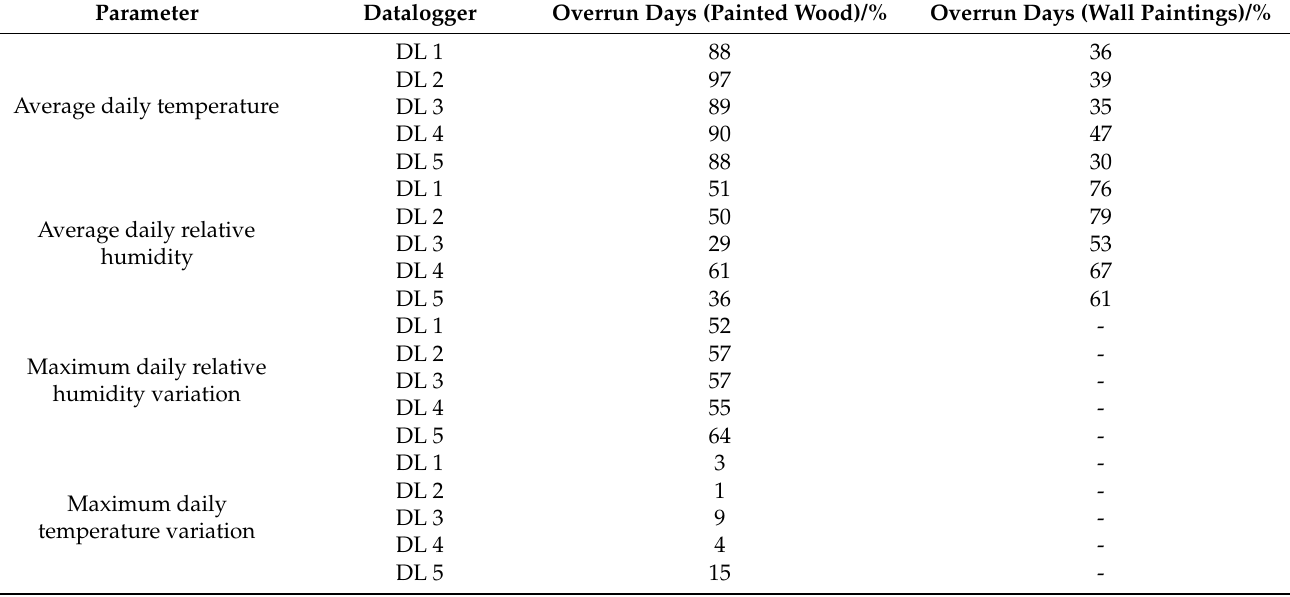
Table 3. Percentage of overrun days of the limits indicated in the UNI 10829:1999 technical